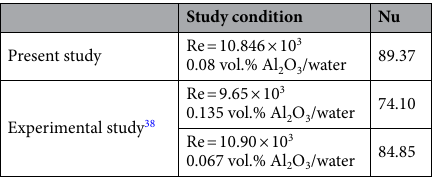
Table 1. CFD verification